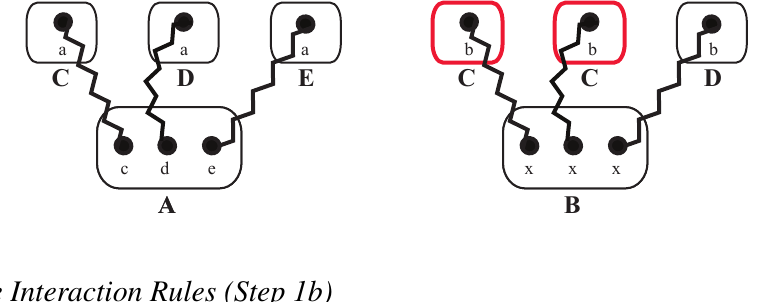
Figure 3. Illustration of binding site specifications with generic or with specific binding sites. On the left, molecule A has three specific sites , c , d and e . The elementary molecules , C , D and E , are connected to molecule A by using the appropriate binding site of the lower case name only—site a is suitable for molecule A only. Those specific binding sites do not allow the link between A and C twice, due to the fact that only one site c exists. Molecule B , on the right, in contrast, has three times the same site , x . Here, the underlying rules would allow any molecule from { C, D, E } to bind to any binding site, x , reducing the number of necessary rules to describe the system. As a result, it would not be guaranteed that the molecules binding to B are distinct, as exemplified by two molecules, C , and one molecule, D , binding to B